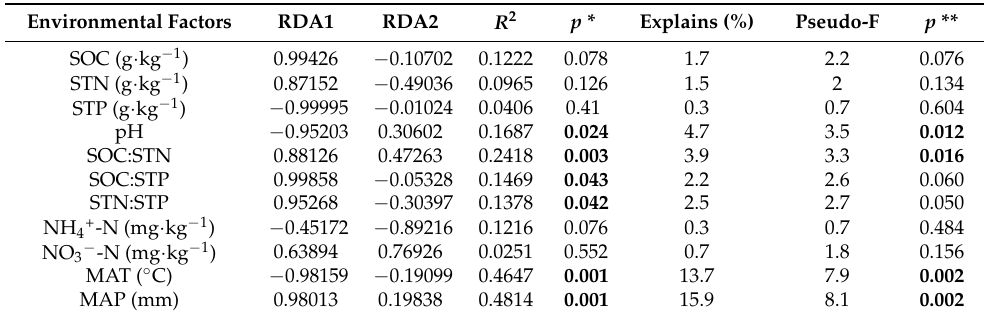
Figure 3. Redundancy analysis (RDA) for the leaf stoichiometric indices of P. crassifolia and environmental indices, includ- ing ratios of soil nutrients, for elevation. LC = leaf C concentration, LC:LN = LC:LN, LC:LP = LC:LP, LN:LP = LN:LP, MAP = mean annual precipitation, MAT = mean annual temperature, LN = leaf N concentration, NH + − N = soil nitrate nitrogen, LP = leaf P concentration, SOC = soil organic carbon, STN = soil total nitrogen, nitrogen, NO − 3 STP = soil total phosphorus. Table 3. The dominant factors influencing leaf stoichiometry of P. crassifolia across the elevational gradient based on